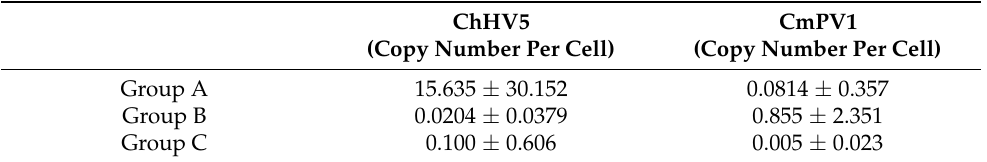
Table 4. Mean viral load (reported as copy number per cell ± standard deviation) detected in the three different biological sample types screened in this study; Group A (FP Tumours), Group B (Non-tumoured skin from turtles with FP tumours) and Group C (Skin from non-tumoured